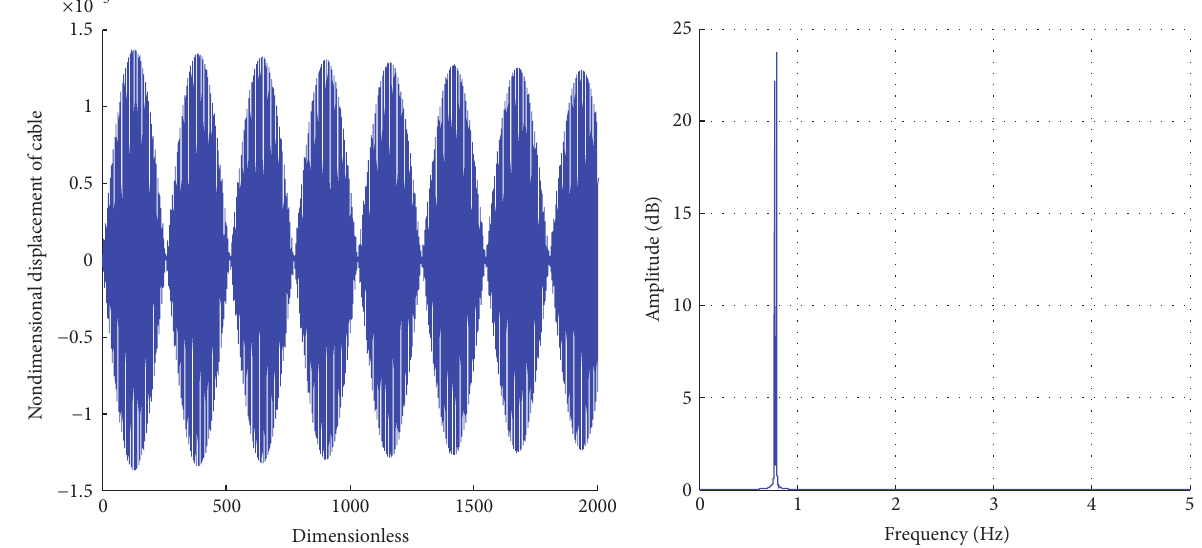
Figure 7: Dimensionless displacement response time history and amplitude-frequency characteristic curve of the deck beam